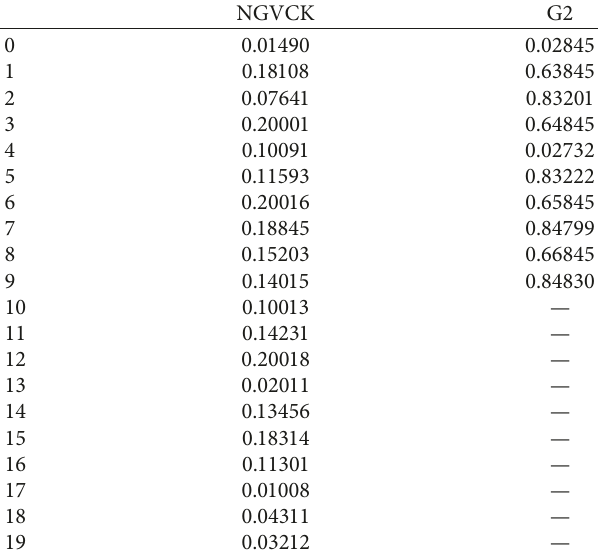
Table 2: Results of the proposed hybrid signal and encryption obfuscation (S&E) for different virus groups with the Mishra